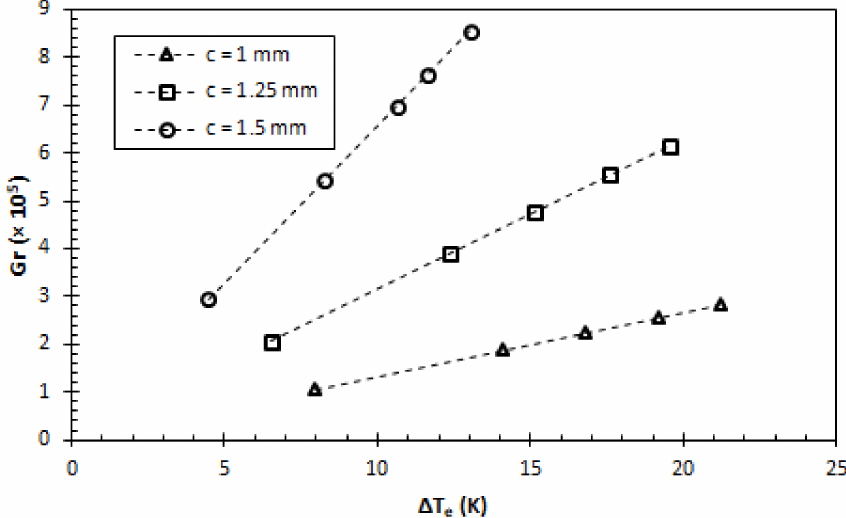
Figure 13. The plot of Grashof number from different circular pin fin gaps.